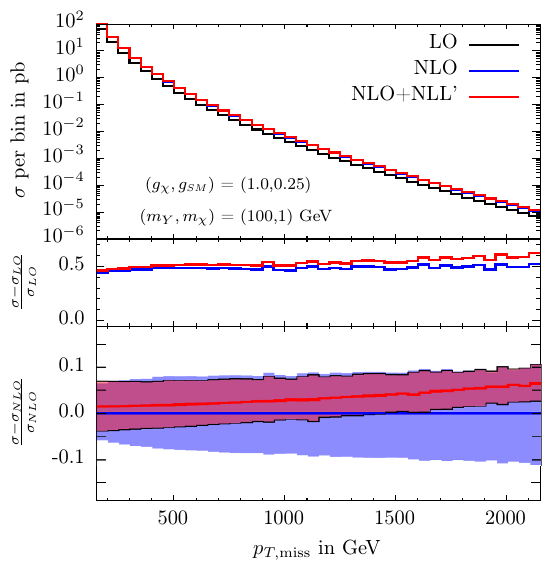
Figure 3 . The missing transverse-momentum distribution for ( m Y ; m (cid:31) ) = (100 ; 1) GeV is shown in the upper panel at LO, NLO, and matched NLO+NLL’ accuracy. In addition, the K-factors with respect to the LO prediction (middle panel) and the scale variation of the NLO and matched NLO+NLL’ predictions (lower panel) are